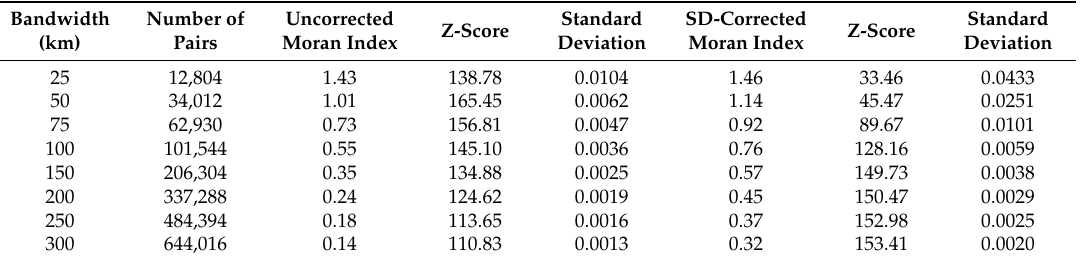
Figure 5. Moran ( left ) and Geary (right ) autocorrelation indices with bandwidth dmax varying from Figure 5. Moran (left) and Geary ( right) autocorrelation indices with bandwidth 𝑑𝑚𝑎𝑥 varying from 25 to 250 km. In yellow without SD-correction, in green with SD-correction. 25 to 250 km. In yellow without SD-correction, in green with SD-correction. Table 1. Uncorrected and SD-corrected Moran index values for growing Table 1. Uncorrected and SD-corrected Moran index values for growing bandwidths.